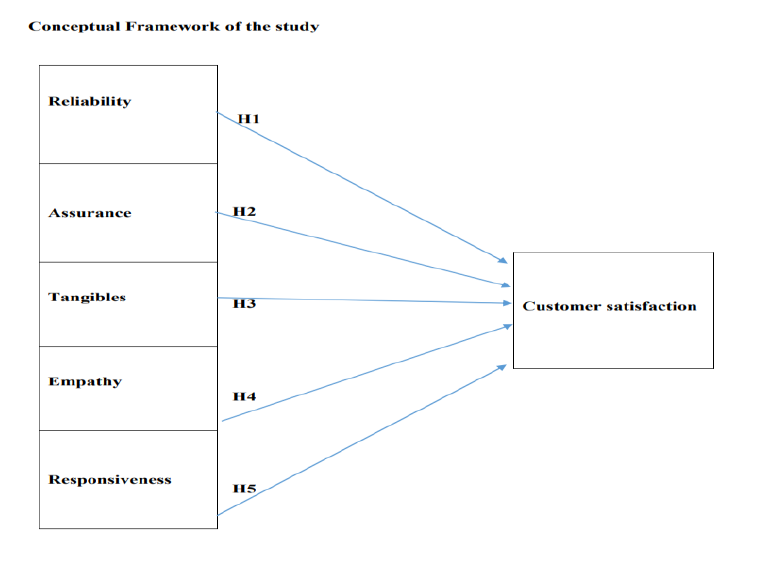
Figure 3: Conceptual Framework of The